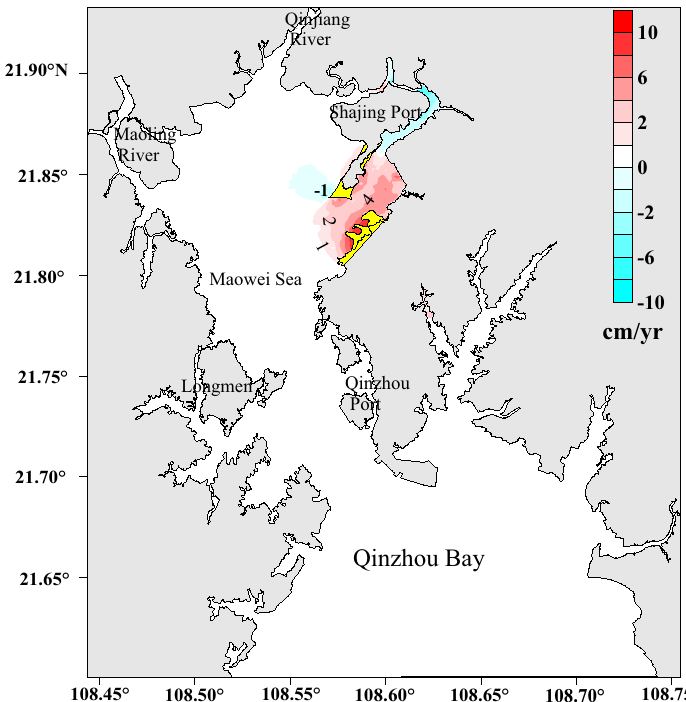
Figure 8. The variations of erosion and deposition in sediment after the project. The figure was plotted with Surfer10 Software (https:// www. golde nsoft ware. com/ produ cts/